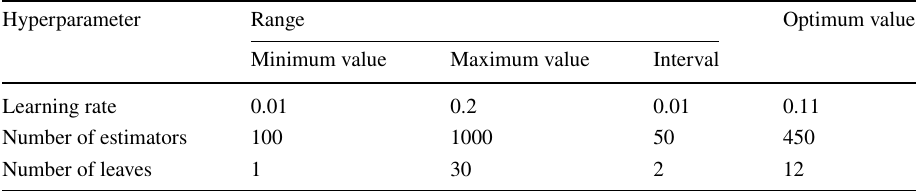
Fig. 8 Predicted depth of the light gradient boosting machine (LightGBM) model under dif- ferent return periods: a 5, b